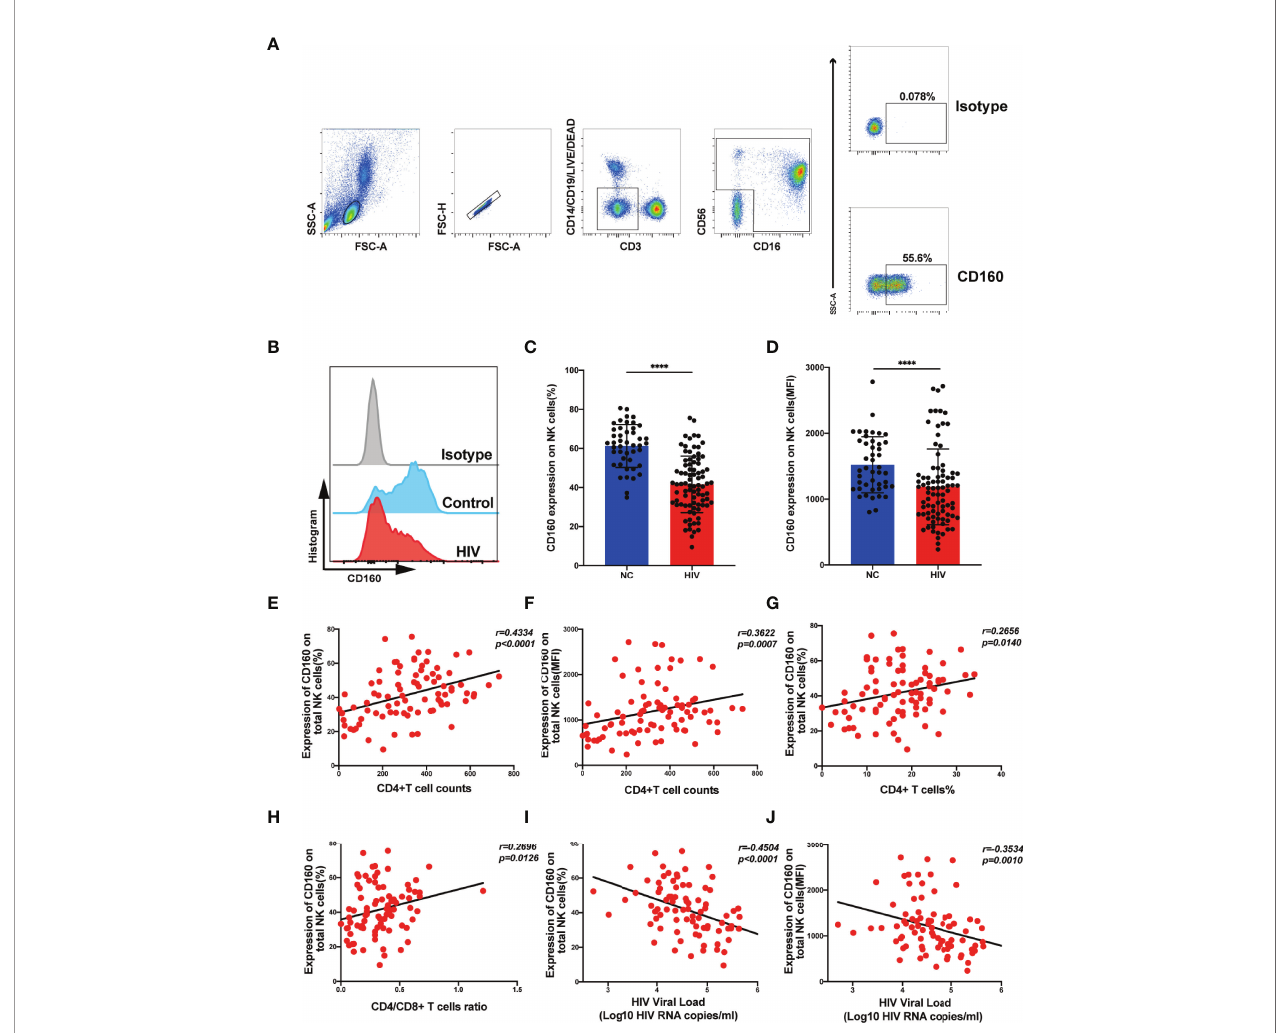
FIGURE 1 | CD160 expression on NK cells is reduced in HIV-infected individuals and negatively associated with HIV disease progression. (A) Gating strategy for human CD160 + NK cells. Peripheral blood mononuclear cells were stained with Fixable Viability Stain 620 (Percp-cy5.5), anti-CD3 (APC-cy7), anti-CD14 (Percp- cy5.5), anti-CD19 (Percp-cy5.5), anti-CD16 (APC), anti-CD56(PE-cy7), and anti-CD160 (PE) monoclonal antibodies, and total NK cells were determined as CD3/ CD14/CD19-negative lymphocytes expressing CD56 and/or CD16. CD160 expression was gated based on an isotype control. (B) Representative histograms showing phenotypic results for HIV-infected individuals and HIV-negative controls (NC). Light-gray, Isotype control; blue, HIV-negative controls; red, HIV-infected individual. (C, D) Percentage (C) and mean fl uorescence intensity (MFI) (D) of CD160 expression on total NK cells in HIV-infected individuals (n = 85) and negative controls (n = 45). (E, F) Correlation between the percentage (E) or MFI (F) of CD160 expression on total NK cells and CD4 + T cell counts (cells/mm 3 ) in HIV-infected individuals (n = 85). (G) Correlation between the percentage of CD160 + NK cells and the proportion of CD4 + T cells in peripheral blood from HIV-infected individuals (n = 85). (H) Correlation between the percentage of CD160 expression on total NK cells and CD4/CD8 T cell ratio in peripheral blood from HIV-infected individuals (n = 85). (I, J) Correlation between the percentage (I) or MFI (J) of CD160 expression on total NK cells and HIV plasma viral load (VL) in HIV-infected individuals (n = 84). The mean fl uorescence intensity of CD160 in panels (D, F, J) was from total NK cells. A non-parametric Mann-Whitney U test was used for comparisons between two groups. A Spearman ’ s rank test was applied for correlation analysis; ****P < 0.0001; ns, no signi fi cance. In (C, D) , data are represented as means ±